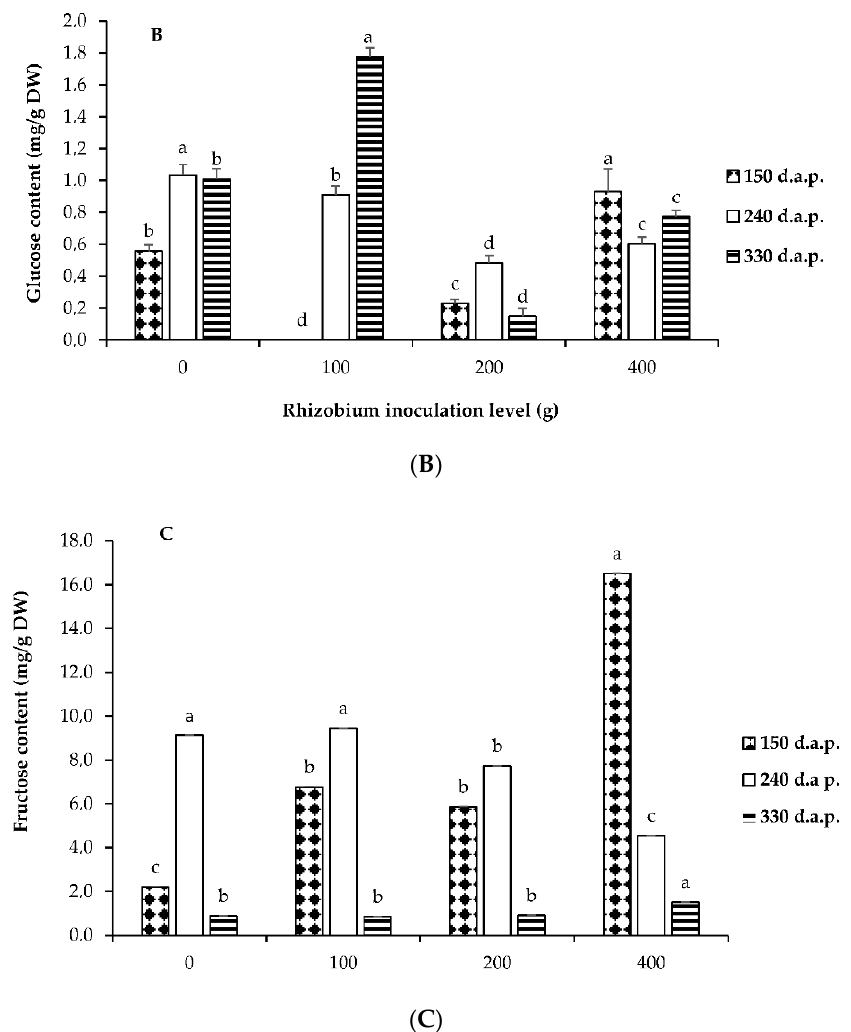
Figure 2. Accumulation of sucrose ( A ), glucose ( B ), and fructose ( C ) in response to four rhizobium inoculation levels and different days after planting of L. frutescens . Rhizobium inoculation treatments 0 = control (no rhizobium); 100; 200 and 400 g of rhizobium per 100 kg of seeds of L. frutescens at 150; 240 and 330 d.a.p. Bars followed by different letters are significantly different at p ≤ 0.05.